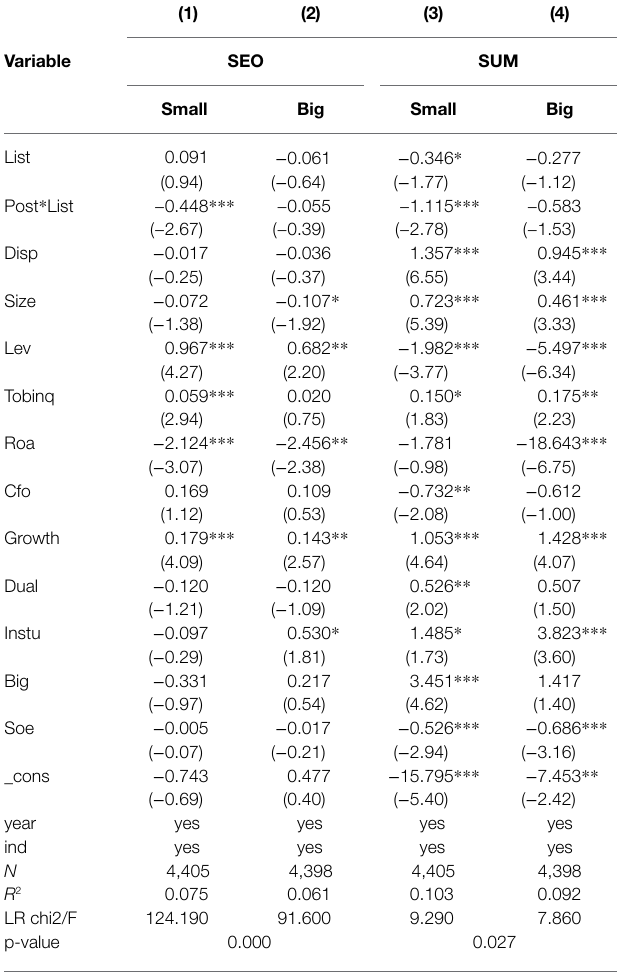
TABLE 9 | Deregulation of short selling and private placements of companies: analysts track numbers.